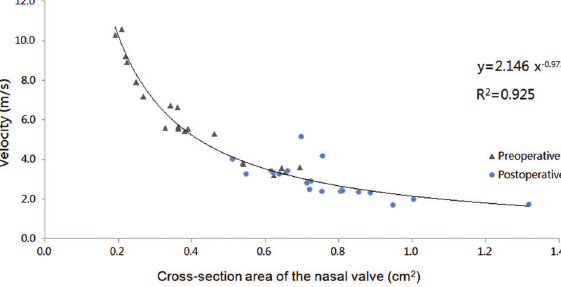
Figure 6. Pre- and postoperative unilateral velocity vs cross- sectional area at the nasal valve on the narrow side of nasal cavity.